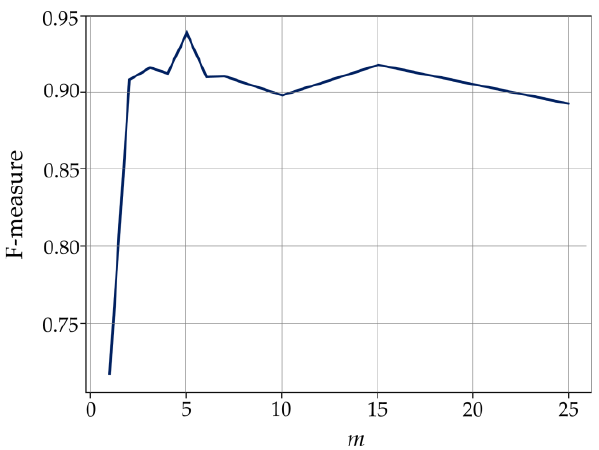
Figure 7. Evaluation of the number of linear band combinations m.